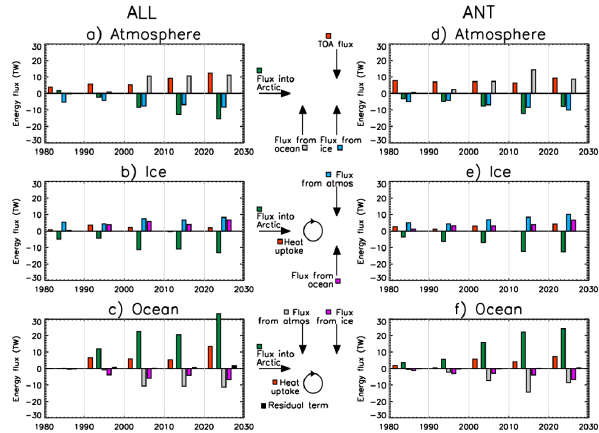
Fig. 5. Decadal means of terms in the Arctic heat budget for the ALL ensemble mean (a–c) and the ANT ensemble mean (d–f) . For each term, the time mean of the equivalent periods in the control runs from 1980–2030 has been subtracted. The sign convention is that denoted by the arrows: positive inward for all fluxes. The colour scheme is the same as that used in Fig.